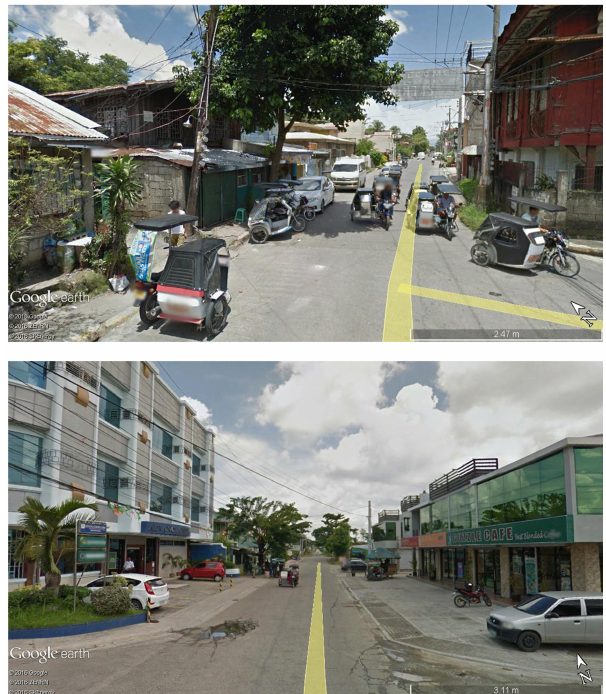
taken from Google Earth software. The classification pro-